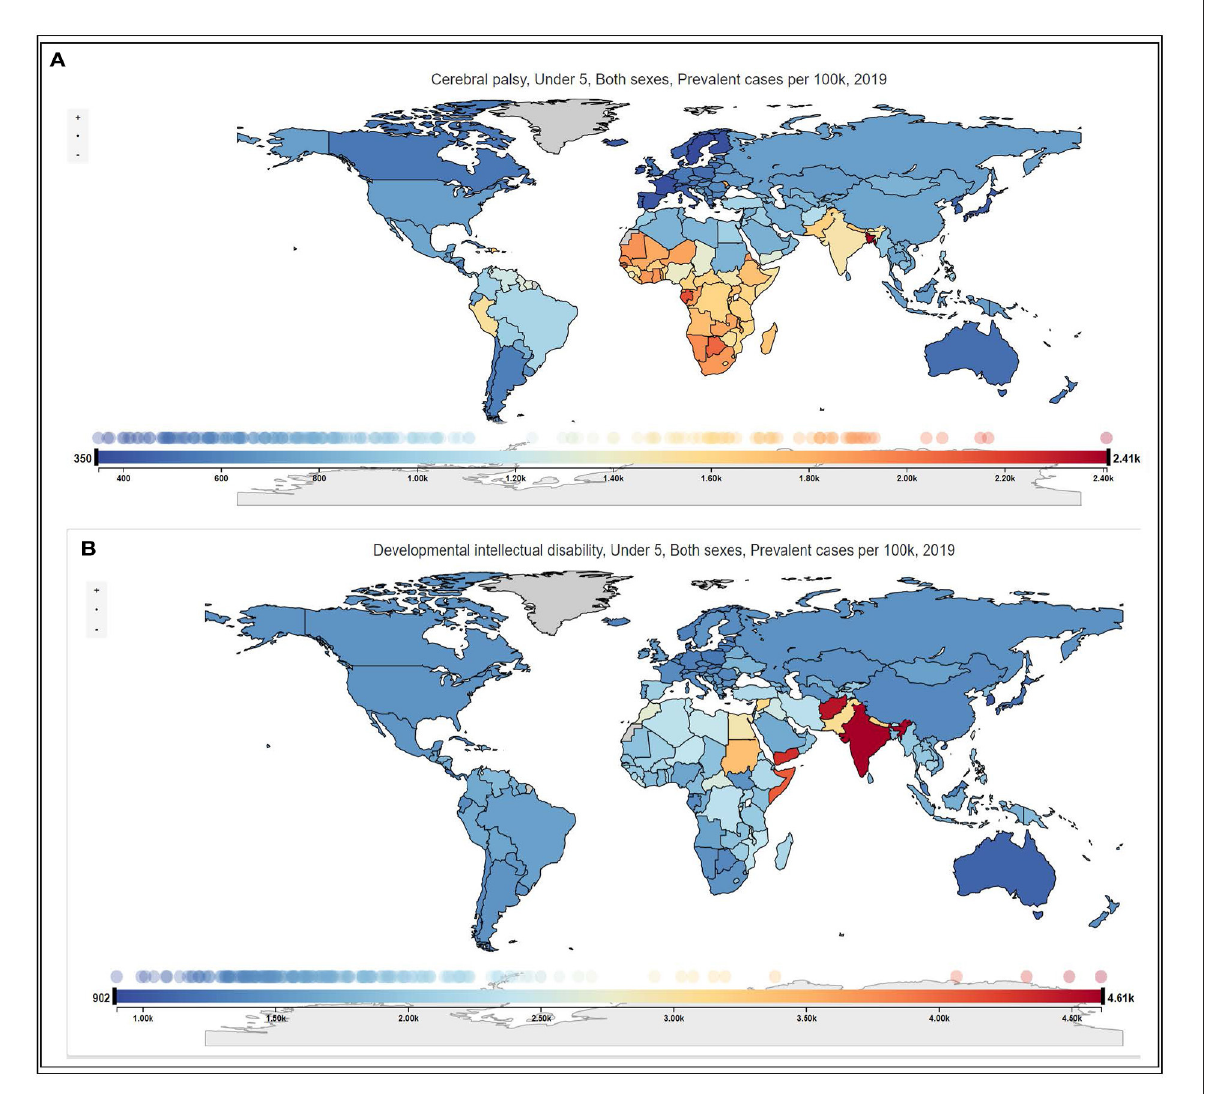
FIGURE2 (A,B) Global prevalence per 100,000 population of cerebral palsy and developmental intellectual disability among children under 5 years in